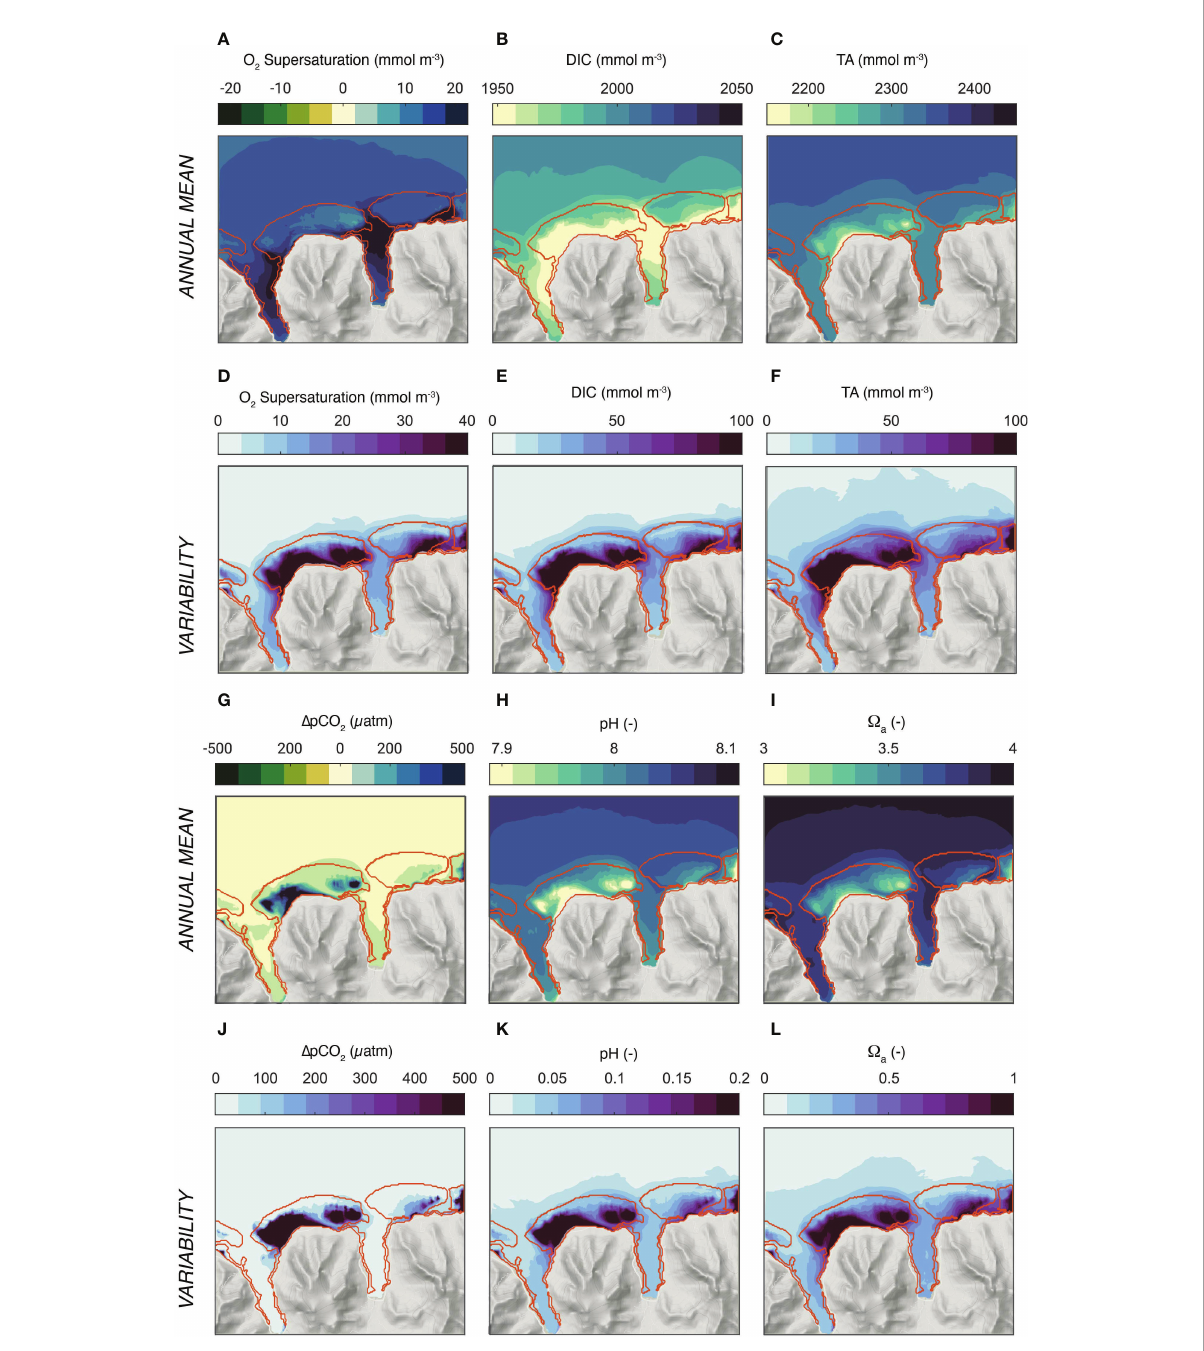
FIGURE 6 Simulated distribution of oxygen and the parameters of ocean carbonate system. (A-C) and (G – I) depict the annual mean concentrations, while (D-F) and (J-L) show the variability (one standard deviation). (A, D) Surface excess oxygen, i.e., O 2 - O 2 sat , (B, E) DIC, (C, F) Total Alkalinity (TA), (G, J) surface D ; p CO 2 = p CO 2 - p CO 2 atm, (H, K) pH, and (I, L) Ω a , the saturation state with respect to aragonite. The annual mean and standard deviations were computed from the simulations for the three wave regimes, taking into account their relative contribution to the annual